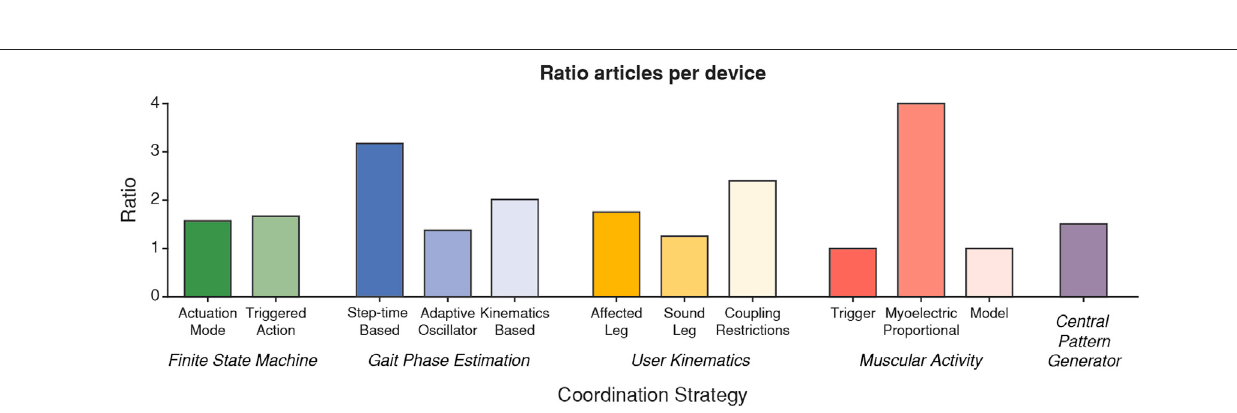
FIGURE 9 | Average number of articles per device in each of the coordination strategies analyzed.